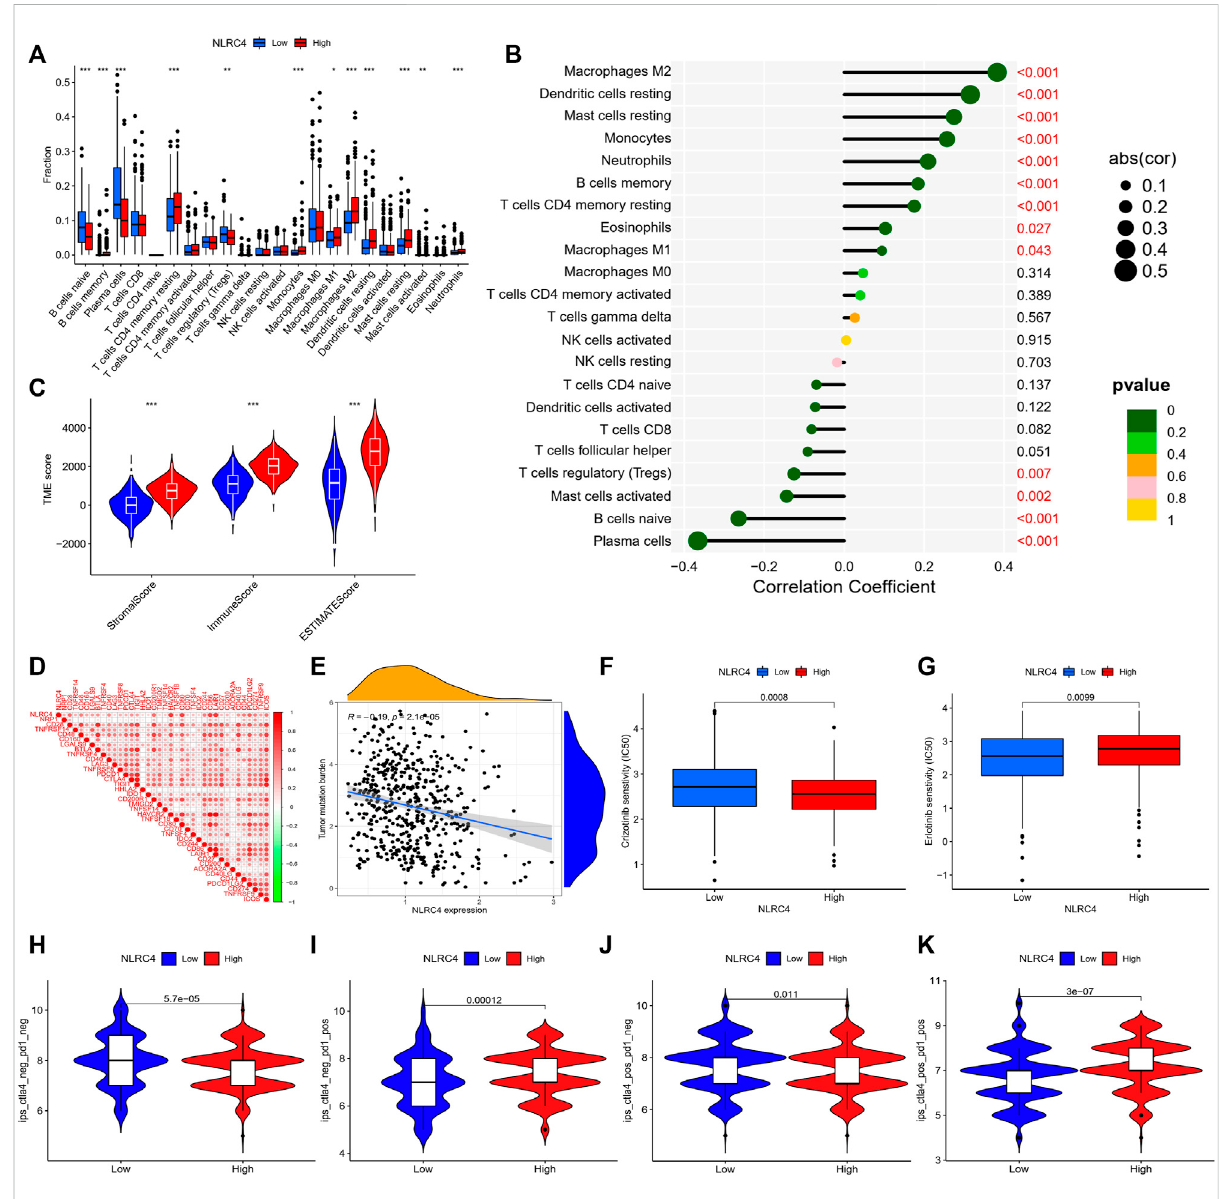
FIGURE 12 (A) In fi ltrating levels of 22 immune cell types between high- and low-expression groups. (B) Correlation coef fi cient analyses of NLRC4 and different immune cells. (C) Tumor microenvironment between high- and low-NLRC4-expression groups (wilcox test, *** p < 0.001). (D) Correlation of NLRC4 and other immune checkpoints (Pearson cor test). (E) Correlation coef fi cient analyses of NLRC4 and TMB (Spearman cor test). (F,G) Drug sensitivity forLUADwithdifferentNLRC4 expression levels. (H – K) TCIA analyses ofLUAD with differentNLRC4expression levels.(wilcoxtest,